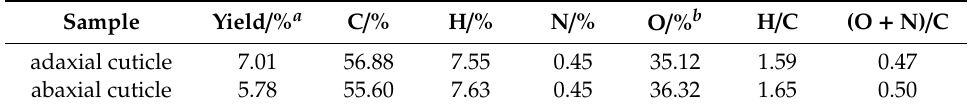
Table1. Yieldsandelementalanalysisofadaxial(PAC)andabaxial(PBC)cuticleof Photiniaserrulata Leaf. Sample Yield / %